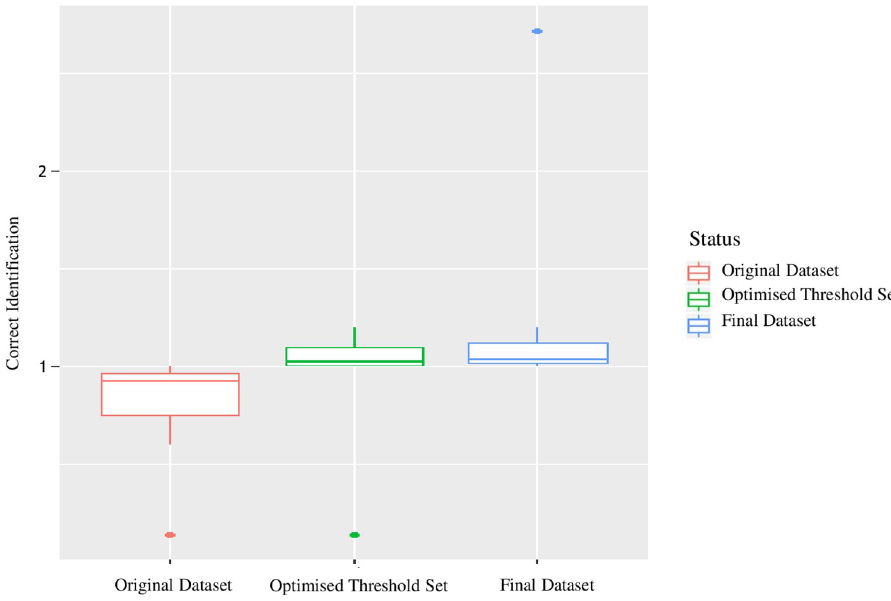
Fig 6. Results of the ANOVA analyses comparing the correct species identification ratio of the original dataset (red), the optimised threshold dataset (green), and the final dataset (blue).